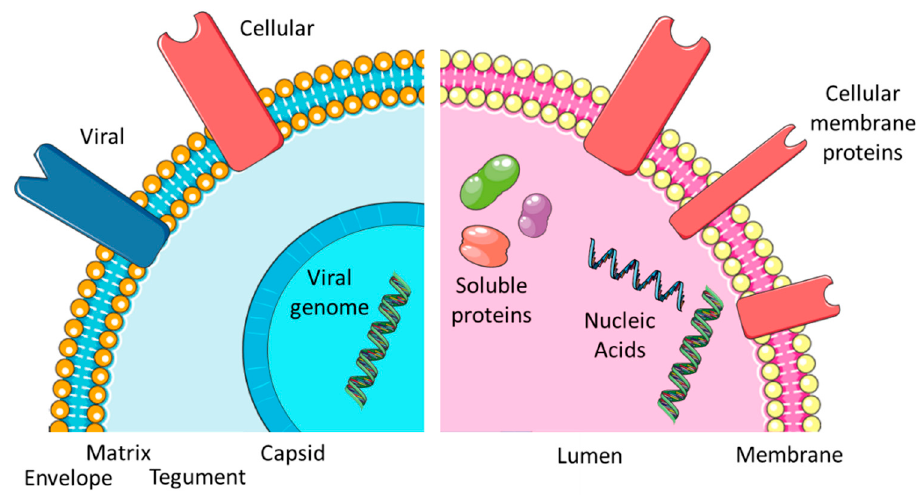
Figure 1. Comparing EXOs and EVIs. Overview of the virus and exosome morphology and con- tent. Table 2. EXO and EVI characteristics.